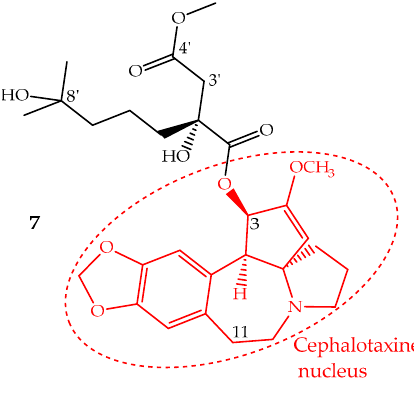
Figure 4. Chemical structure of homoharringtonine also named omacetaxine mepesuccinate ( 7 ) with alkaloid nucleus cephalotaxine (red).